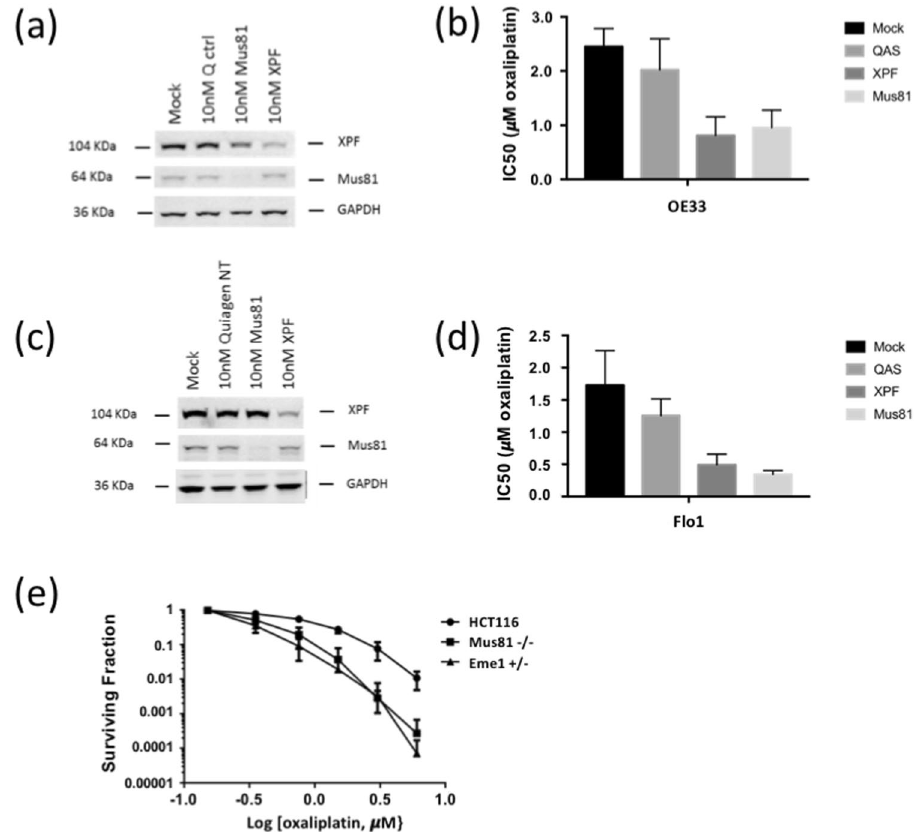
Figure 3. Oxaliplatin sensitivity is increased when cancer cells are deficient in MUS81, XPF or EME1. ( a – f ) siRNA depletion of MUS81 or XPF in two EAC cell lines ( a , b ) OE33 cells and ( c , d ) Flo1 cells. In OE33 cells, oxaliplatin IC 50 was 2.46 μ M ( ± 0.35) in mock-transfected, 2.02 μ M ( ± 0.47) in control-transfected, 0.92 ( ± 0.35, P < 0.01) after MUS81 depletion and 0.77 ( ± 0.33, P < 0.01) after XPF depletion. For Flo1, oxaliplatin IC 50 was 1.70 μ M ( ± 0.47) in the mock- and 1.23 μ M ( ± 0.23) in the control-transfected cells, 0.2 ( ± 0.05, P < 0.01) after MUS81 depletion and 0.34 ( ± 0.18, P < 0.01) after XPF depletion. ( e ) Clonogenic survival of HCT116 colorectal cancer cells is significantly reduced in MUS81 knockout or EME1 haplo-insufficient